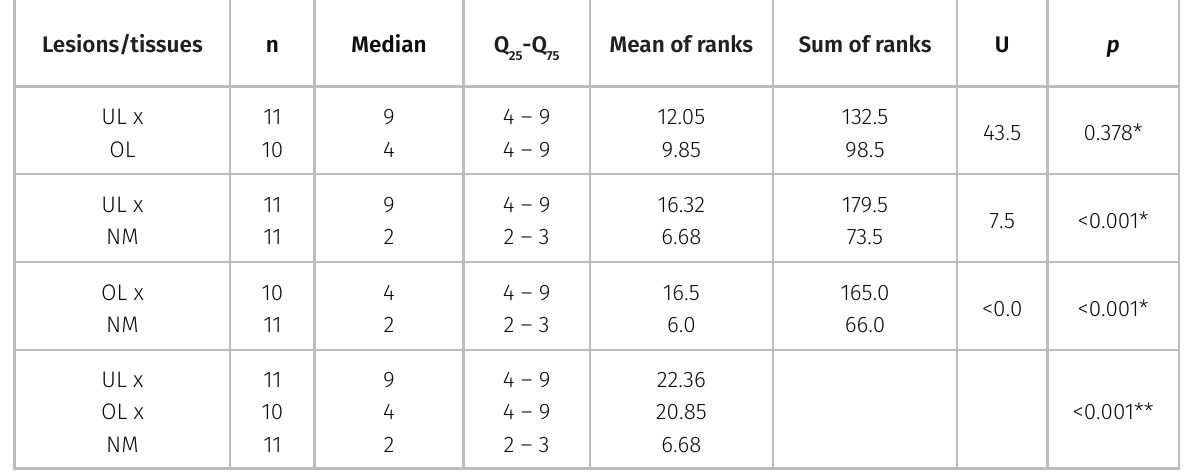
Table III. Distribution of Cripto-1 immunoexpression scores according to the type of lesion.